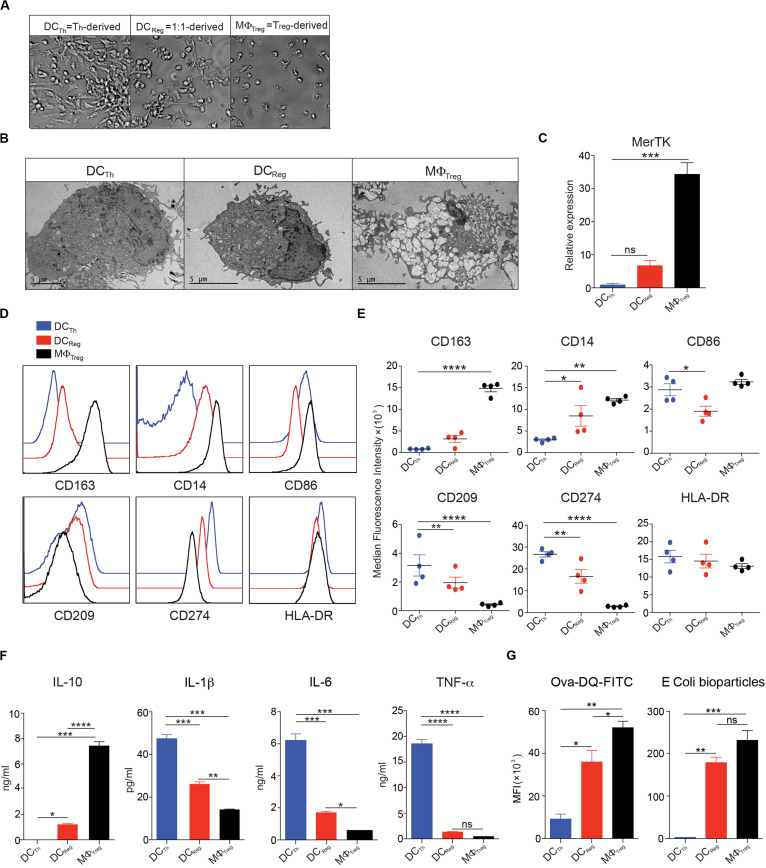
Monocytes cultured with Tregs and Th differentiate into DC-like cells with unique morphology and surface phenotype. (A–G) In the presence of anti-CD3 mAb, CD14+ monocytes were cultured with Tregs (10:1) or memory Th (10:1) alone, or with Tregs and Th at a 10:1:1 ratio. (A) Images were captured with a bright-field DIC microscope on day 4 of culture; original magnification 100X. (B) Transmission electron micrographs of FACS sorted HLA-DR+CD2– cells on day 4 of culture. (C) MerTK in FACS purified HLA-DR+CD2– cells assayed by real-time PCR on day 4 of culture. (D,E) Flow cytometric analysis of monocyte-derived HLA-DR+CD2– cells on day 4 of culture. (F) On day 4, HLA-DR+CD2– cells were purified by FACS, and 200,000 cells were incubated in 200 μl culture medium containing 1 μg/ml LPS. After 16h, cell-free supernatants were assayed by Luminex, and IL-10, IL-1β, IL-6, and TNFα levels are shown. (G) Left: On day 3, 1 μg/ml LPS was added and 16h later cells harvested from the cocultures were incubated with OVA-DQ for 60 min at 37°, and HLA-DR+CD2– cells were analyzed for processing of OVA. MFIs of green signal are shown. Right: Cells harvested from the cocultures were incubated with PE-conjugated E. coli bioparticles for 60 min at 37°C. MFIs of PE in HLA-DR+CD2– cells are shown. Mean ± SEM of 2 independent experiments and > 8 donors. Data are representative of at least 3 independent experiments. *P < 0.05, **P < 0.01, ***P < 0.001, ****P < 0.0001; ns, not significant. Data were analyzed with one-way ANOVA, followed by Dunnett’s test for multiple comparisons.